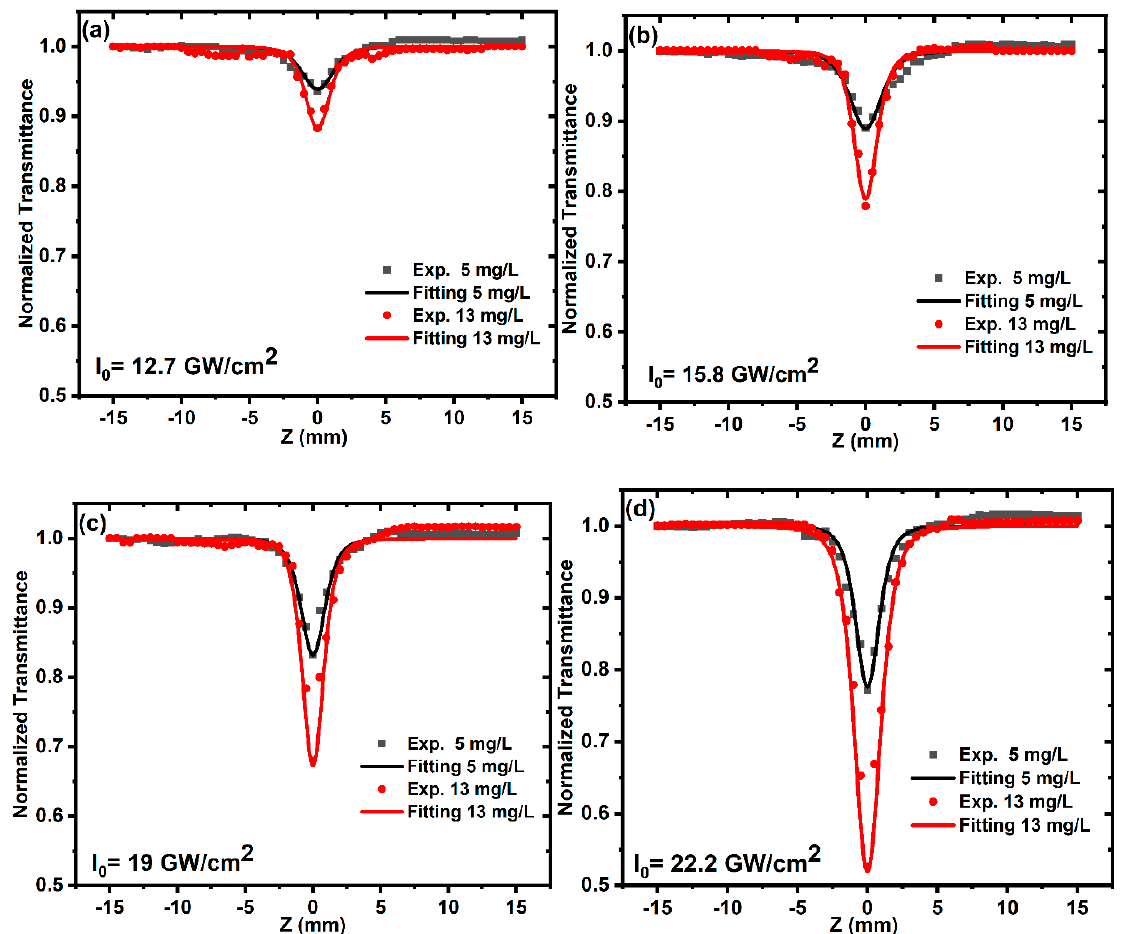
Figure 6. The OA Z–scan transmission of ZnONPs colloids prepared at different concentrations of 5 and 13 mg/L, irradiated by 800 nm, and at different incident peak intensities ( a ) 12.7, ( b ) 15.8, ( c ) 19, and ( d ) 22.2 GW/cm 2 . The points indicate the experimental results, and the solid lines indicate the fits.